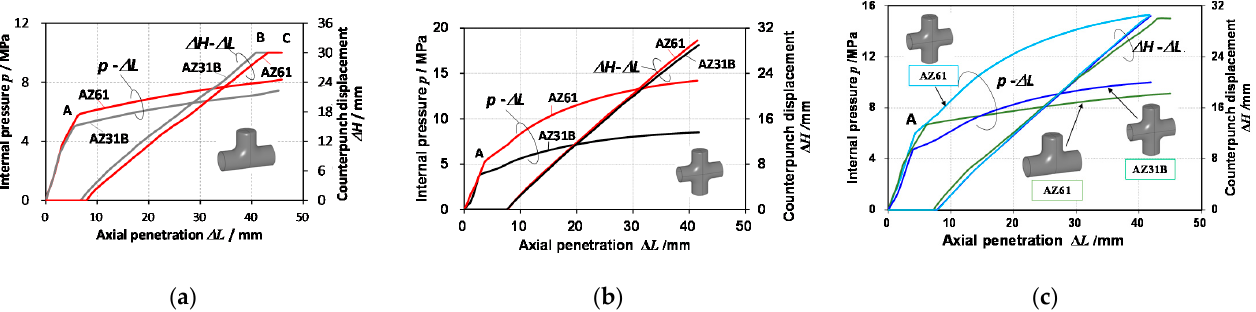
Figure 19. Comparison of optimum loading path for T-shape forming and cross-shape forming of AZ31B and AZ61 at 250 °C. ( a ) T-shape forming; ( b ) cross-shape forming; ( c ) comparison between T-shape forming and cross-shape forming. p : internal pressure, ∆ H : counterpunch displacement, ∆ L : axial penetration.